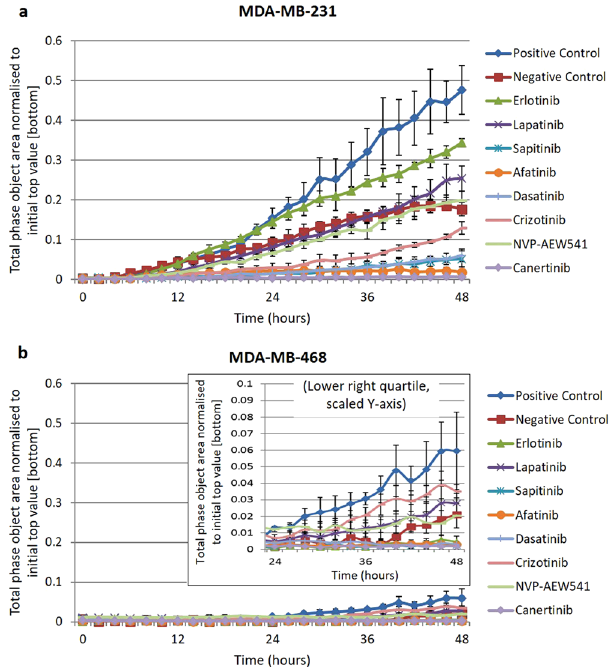
Figure 7. Effects of TKIs on migration of breast cancer cell lines. ( a ) MDA-MB-231. ( b ) MDA-MB-468. Cells were seeded into the top layer of a 96-well cell migration assay plate in 0.5% FBS DMEM together with TKIs at IC50 concentrations, while 10% FBS DMEM (chemo-attractant) was added to the bottom layer. Cells were incubated at 37 °C for 48 hours, with images taken using the Zoom Live-Cell Analysis System (Esso